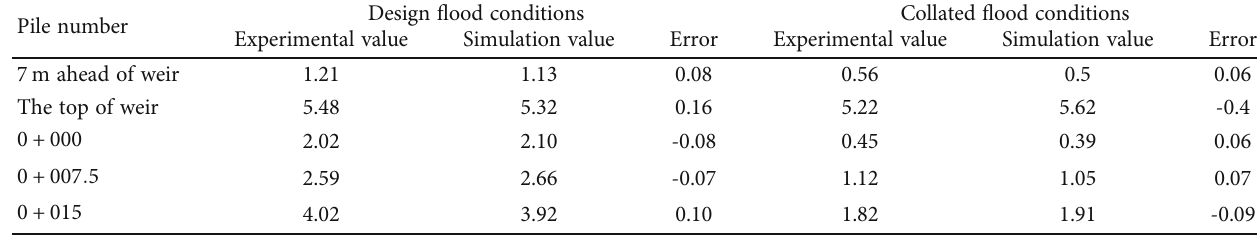
Table 3: The velocity distribution at the entrance section.